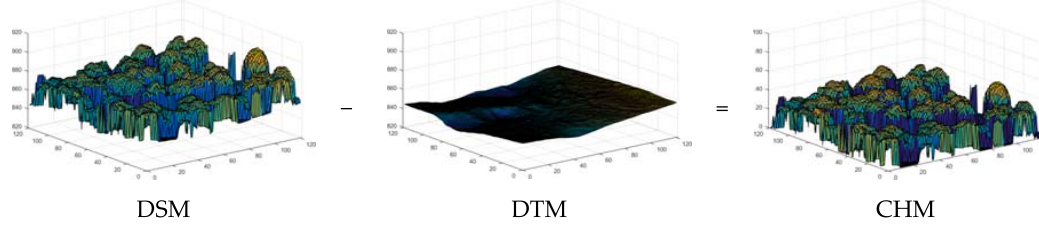
Figure 5. Computing canopy height within each pixel based on the difference between the surface model and the terrain model. DSM = digital surface model; DTM = digital terrain model; CHM = canopy height model.